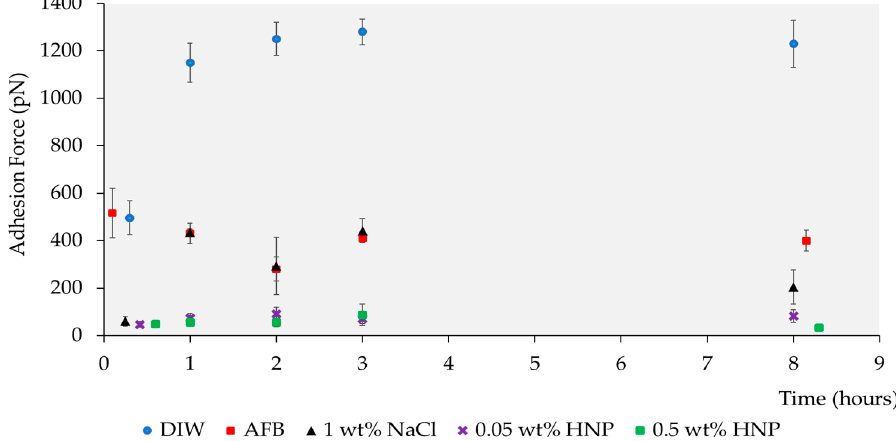
Figure 5. Graph of adhesion force as a function of time between a -CH 3 terminated tip and mica in five test solutions: de-ionized water (DIW); artificial formation brine (AFB); 10,000 ppm sodium chloride (1 wt% NaCl) and solutions of 0.05 wt% and 0.5 wt% silica nanoparticles dispersed in 1 wt% NaCl (0.05 wt% HNP and 0.5 wt% HNP respectively) solutions. Minor discrepancies observed in the case of 1 wt% NaCl and 0.5 wt% HNP are mostly due to evaporation effects which become significant over a long period of time. Each data point is an average of 256 force curve measurements.